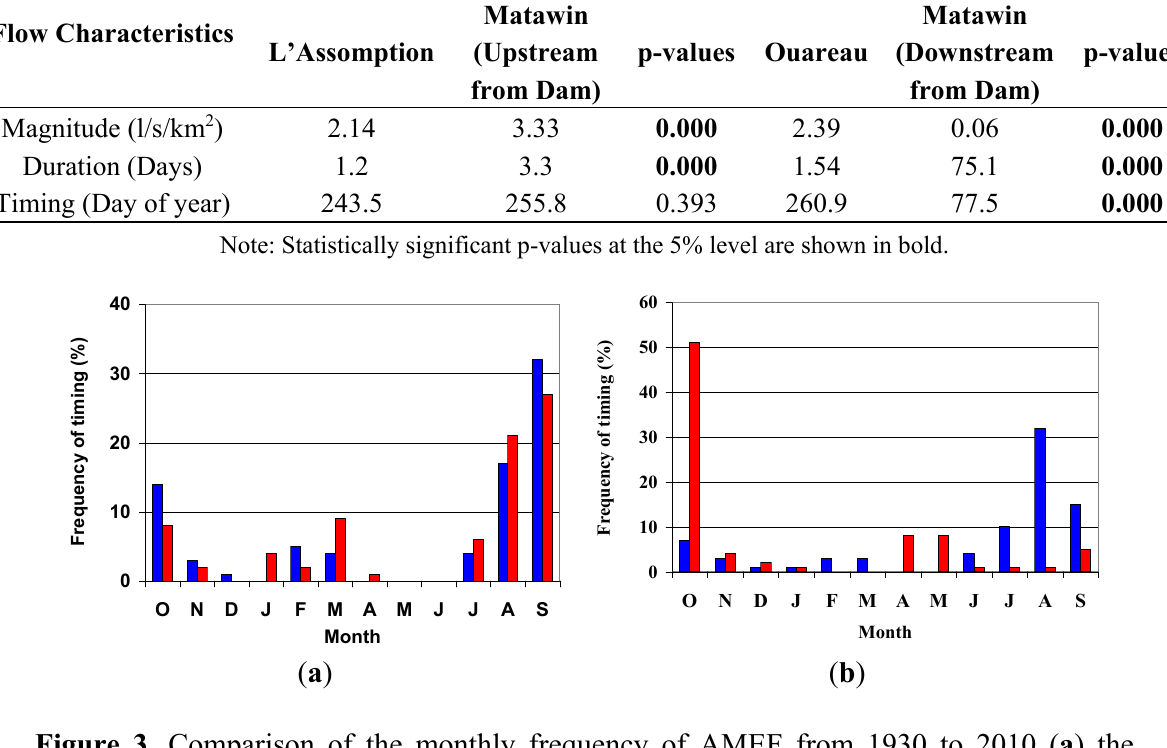
Figure 3. Comparison of the monthly frequency of AMEF from 1930 to 2010 ( a ) the L’Assomption River (blue bars) and Matawin River upstream from the Matawin dam (red bars); ( b ) the Rawdon dam on the Ouareau River (blue bars) and from the Matawin dam on the Matawin River (red